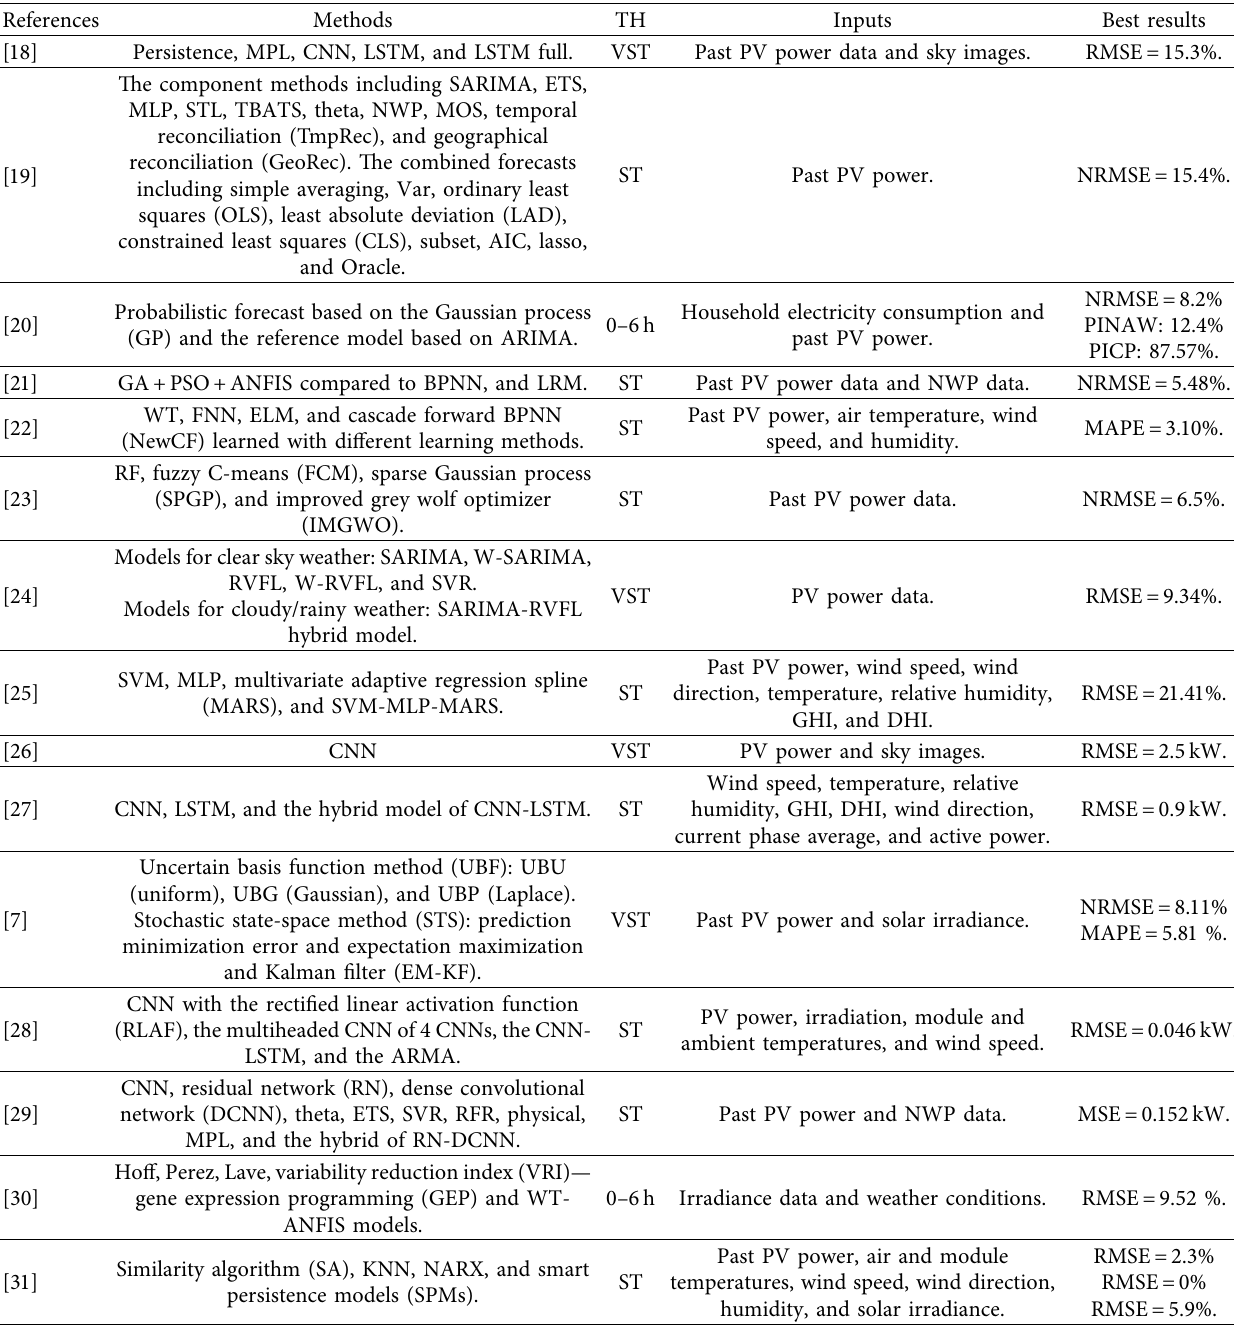
Table 2: Current literature review in the PV power forecasting including the references, methods, time and spatial horizons, and results.